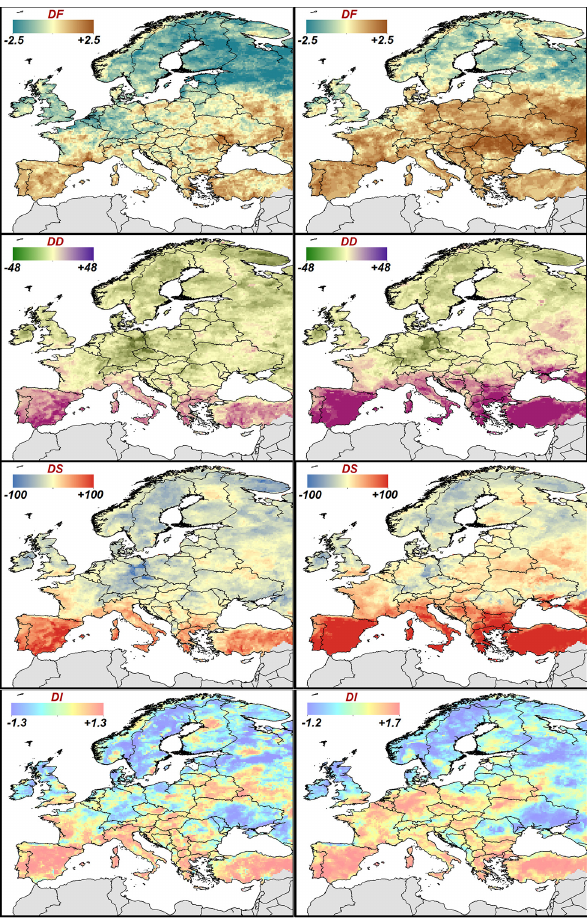
Figure 1. Comparisons between near future and recent past for the frequency (DF), duration (DD), severity (DS), and intensity (DI) of drought events, according to the SPI-12 (left panel) and the SPEI-12 (right panel). All the values are expressed per decade.